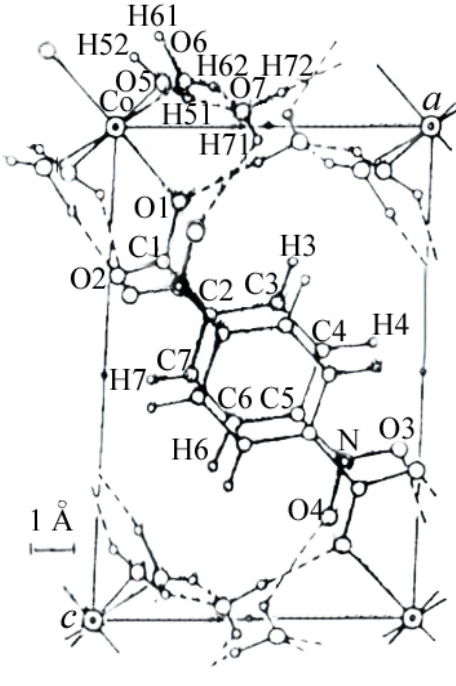
Figure 4 . Crystal structure of Cobalt(II) p -nitrobenzoate complex [31].